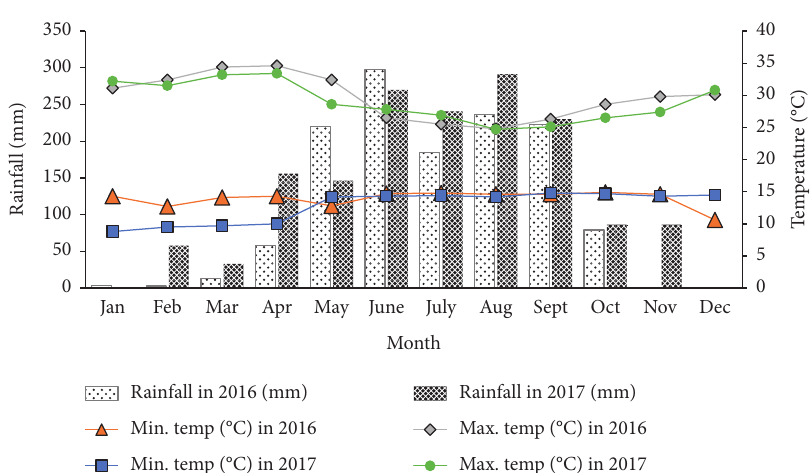
Figure 1: Monthly total rainfall (mm) and mean minimum and maximum temperatures ( ° C) of the experimental station in 2016 and